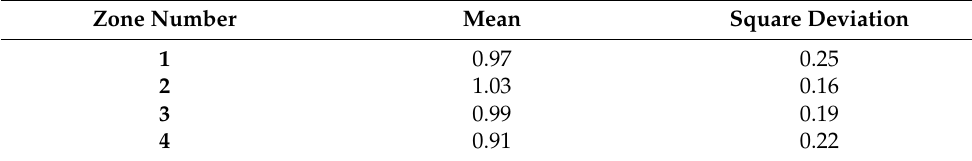
Table 3. Mean and square deviation of A / A ref of different zones of model with θ a = 0 ◦ . Zone Number Mean Square Deviation